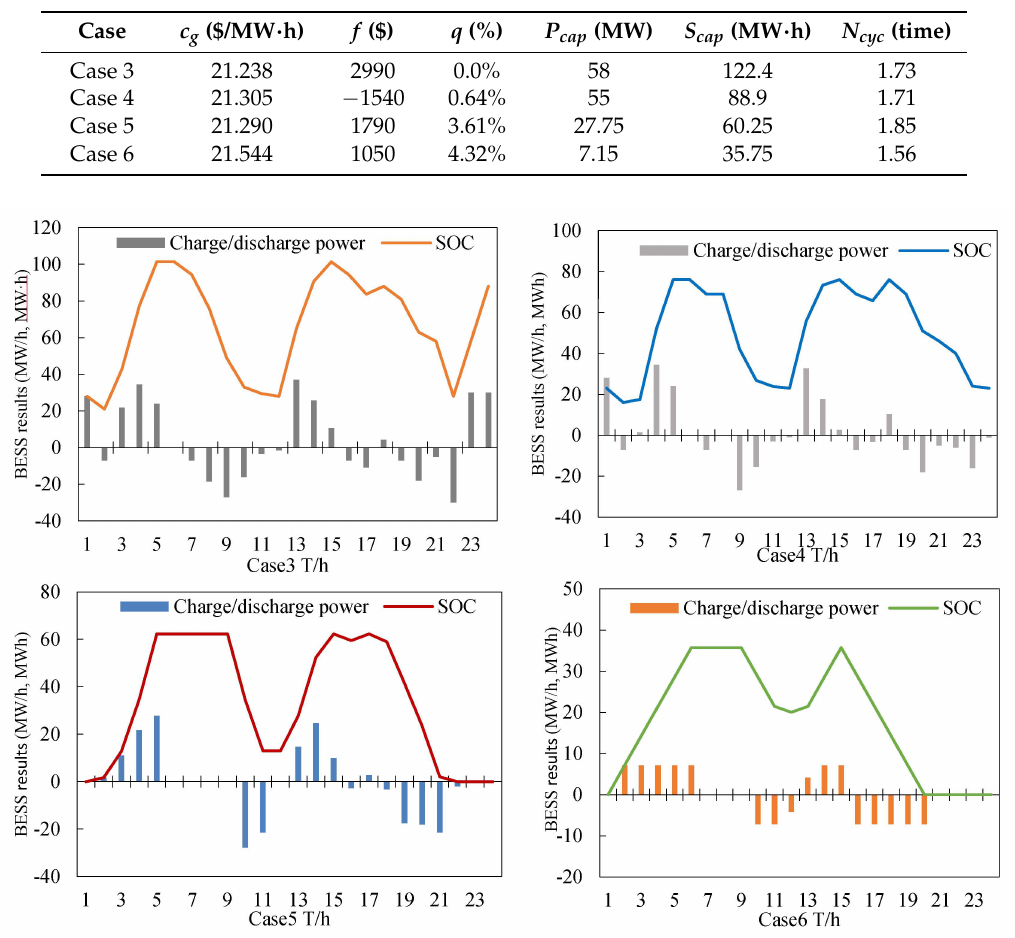
Table 4. Optimal results with BESS for different cases.